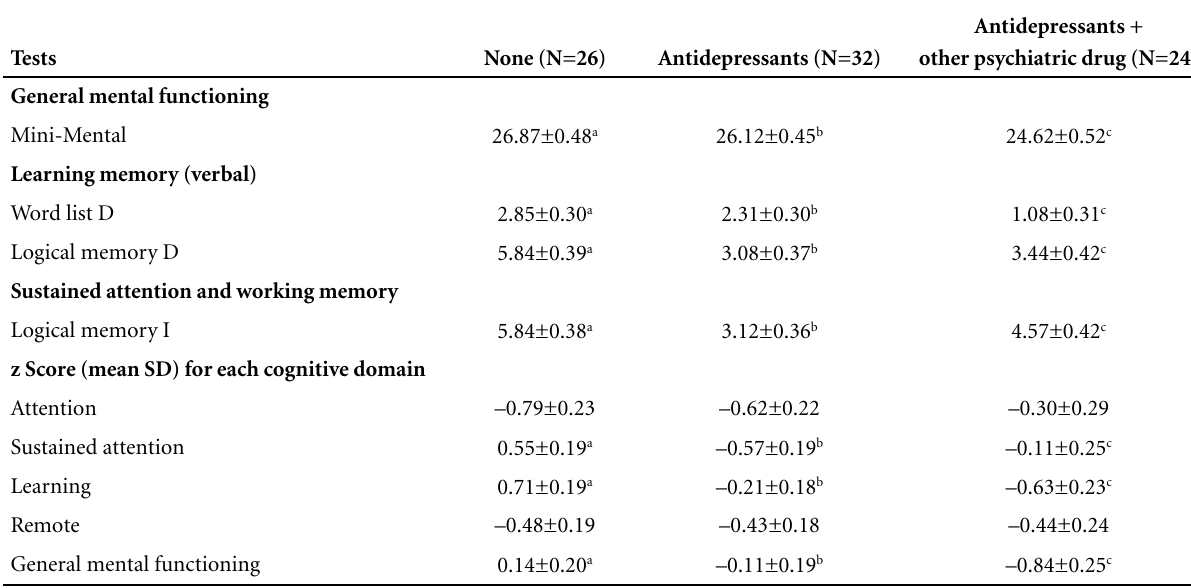
Table 3. Mean±standard error of statistically different test scores among depression patients classified by drug use – and z scores for all cognitive/memory domains multivariate procedures of MANOVA (adjusted for severity of depression, education and